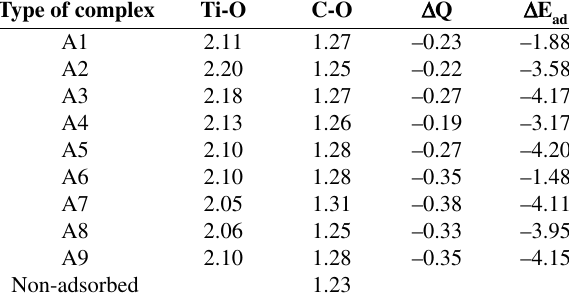
Table 1. Bond lengths (in Å), Mulliken charges (in | e | ) and adsorp- tion energies (in eV) for a C anatase